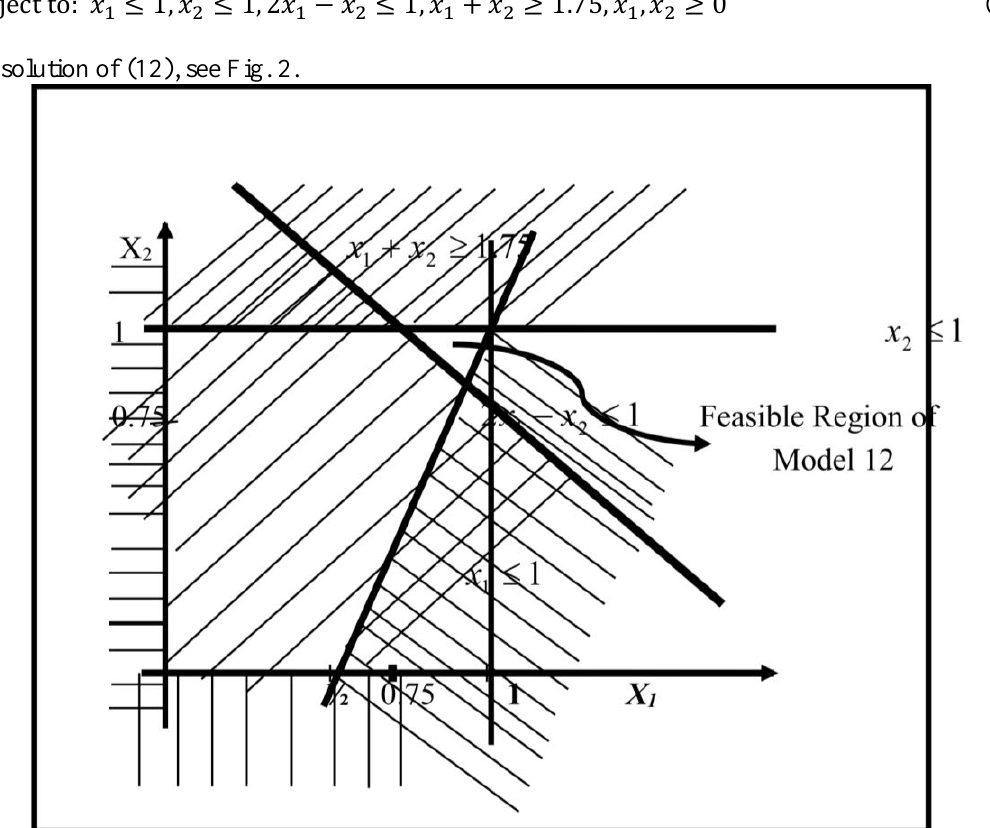
Fig. 2. Schematic presentation of the reduced feasible region after one move in the normal direction with respect to model (12)